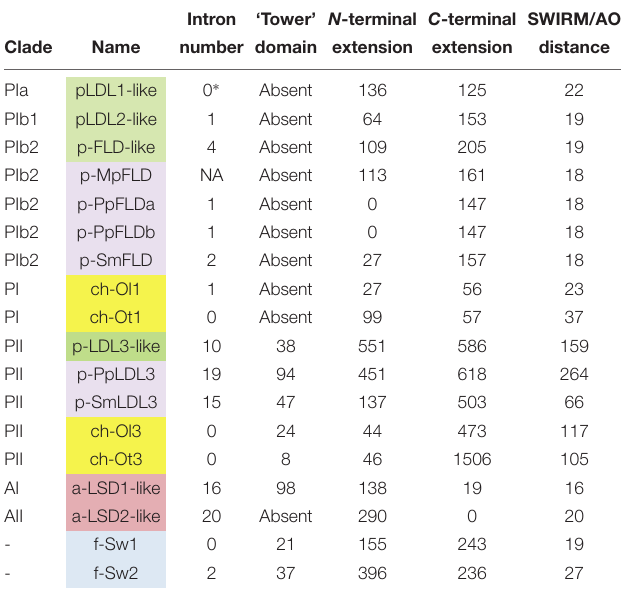
TABLE 2 | Characteristics of LSD1-like proteins in various